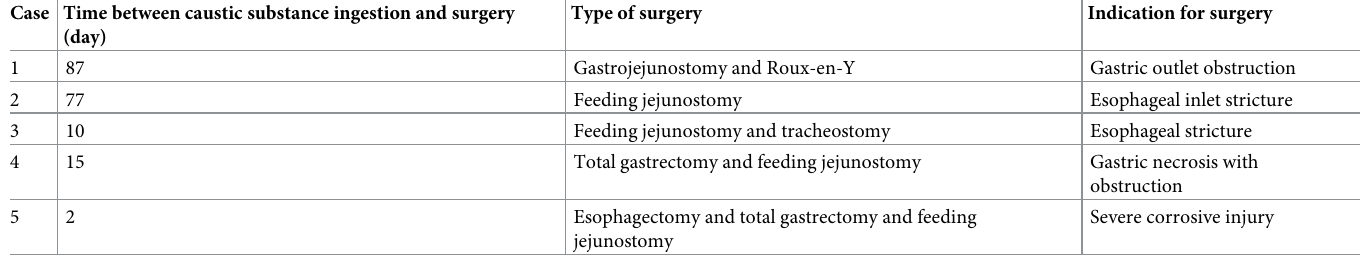
Table 5. Clinical courses of 5 patients with caustic gastrointestinal tract injury who underwent